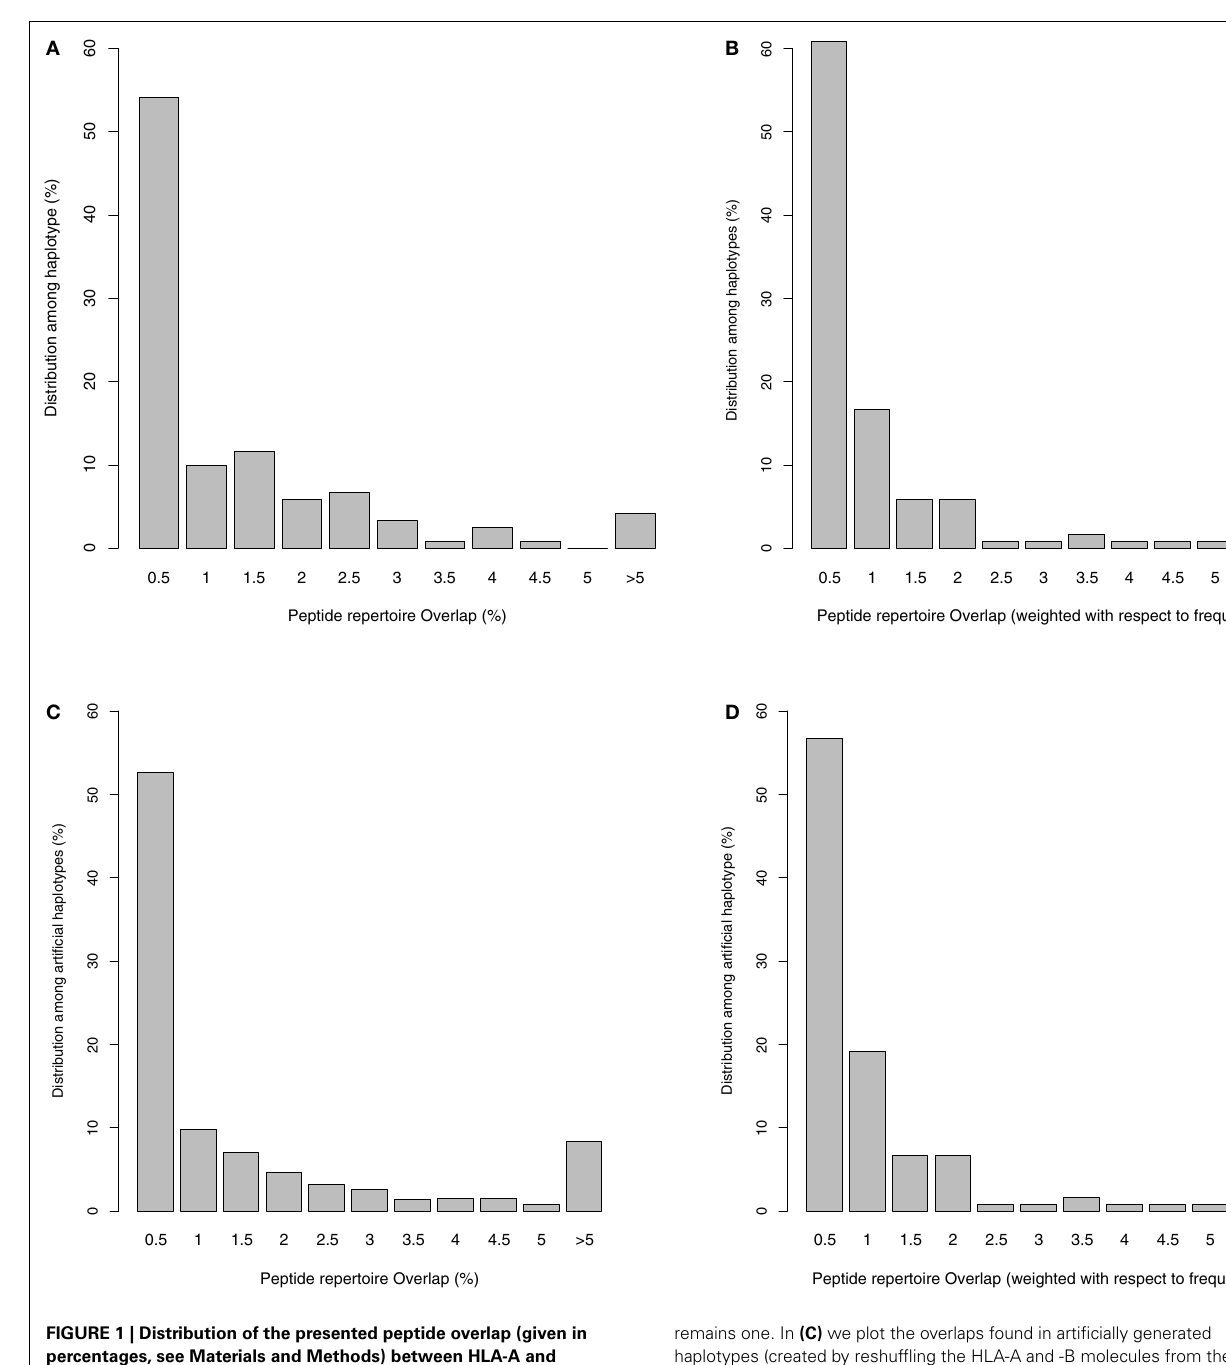
FIGURE 1 | Distribution of the presented peptide overlap (given in percentages, see Materials and Methods) between HLA-A and HLA-B molecules belonging to the same haplotype . (A) The distribution of the peptide overlaps for the 120 unique haplotypes we identified in the US population. (B) The distribution in A is weighted with the frequency of the haplotype in the population. If a haplotype was found in more than one ethnicity in US, we have taken the maximum frequency into account, normalizing the frequencies such that the sum